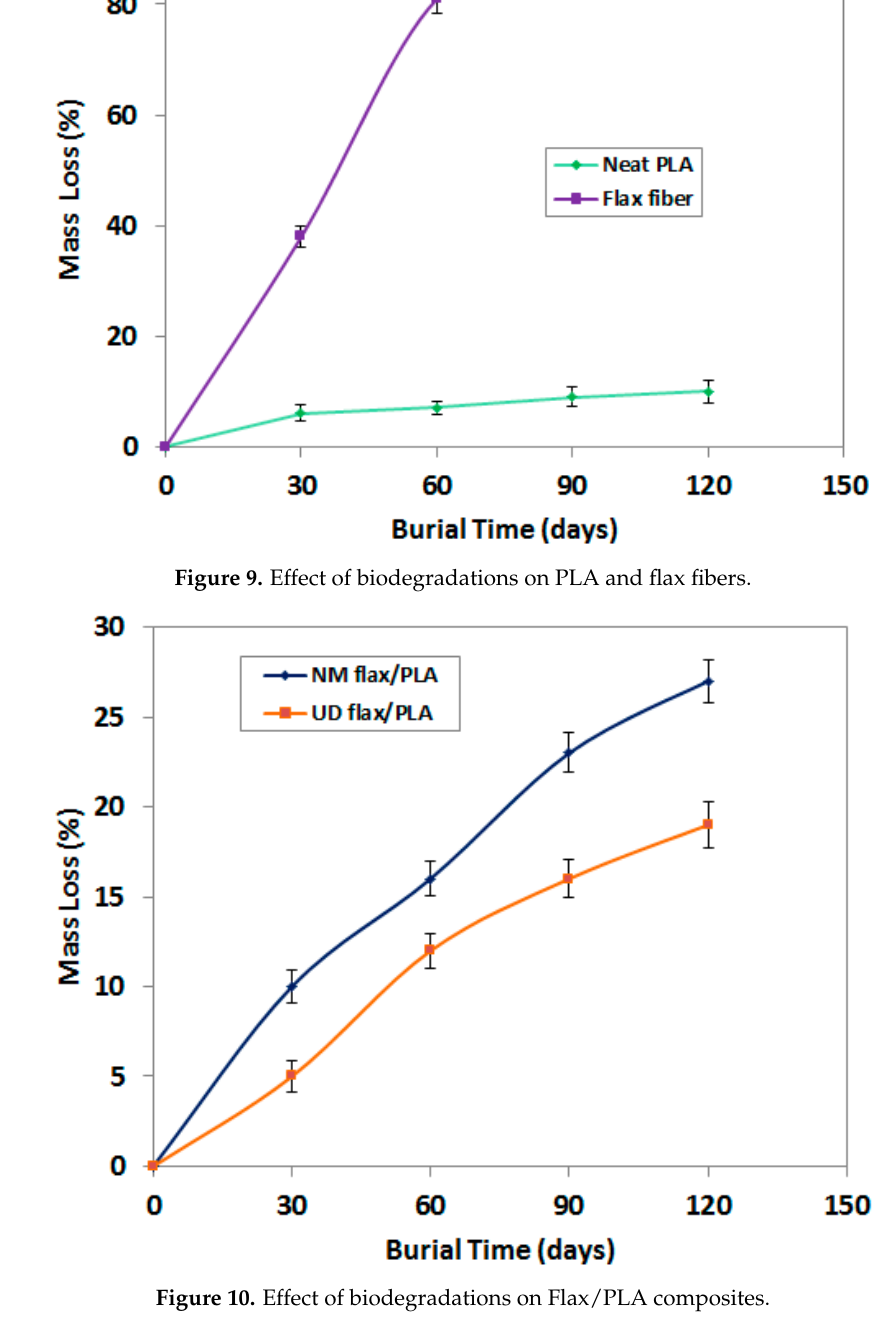
Figure 10. Effect of biodegradations on Flax/PLA composites.